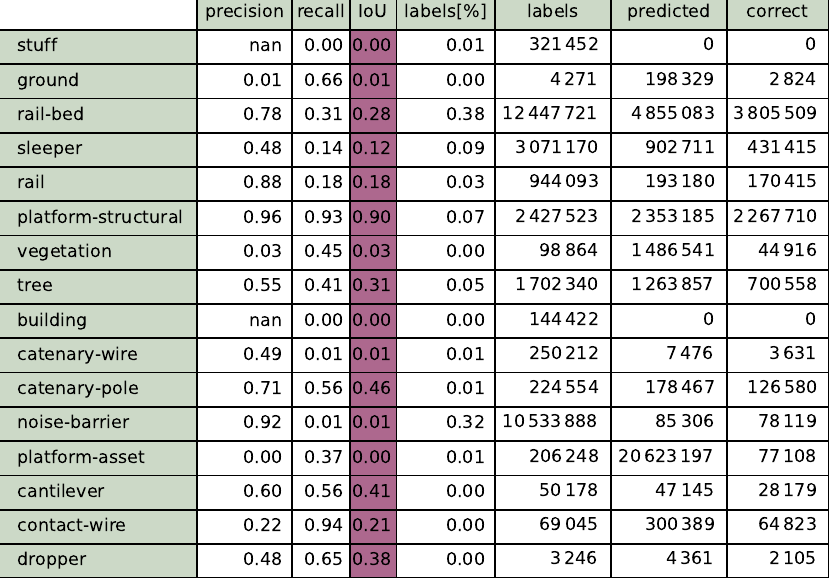
Figure 6. Results for the baseline experiment. The 16-system nn-model was solely trained on synthetic excerpts. The summary shows the test results on the holdout data of the physical dataset.